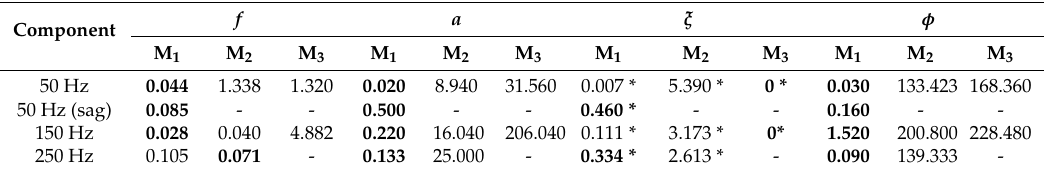
Table 4. Comparative analysis of the proposed method, Prony method (order = 6), and the TLS-ESPRIT (order =